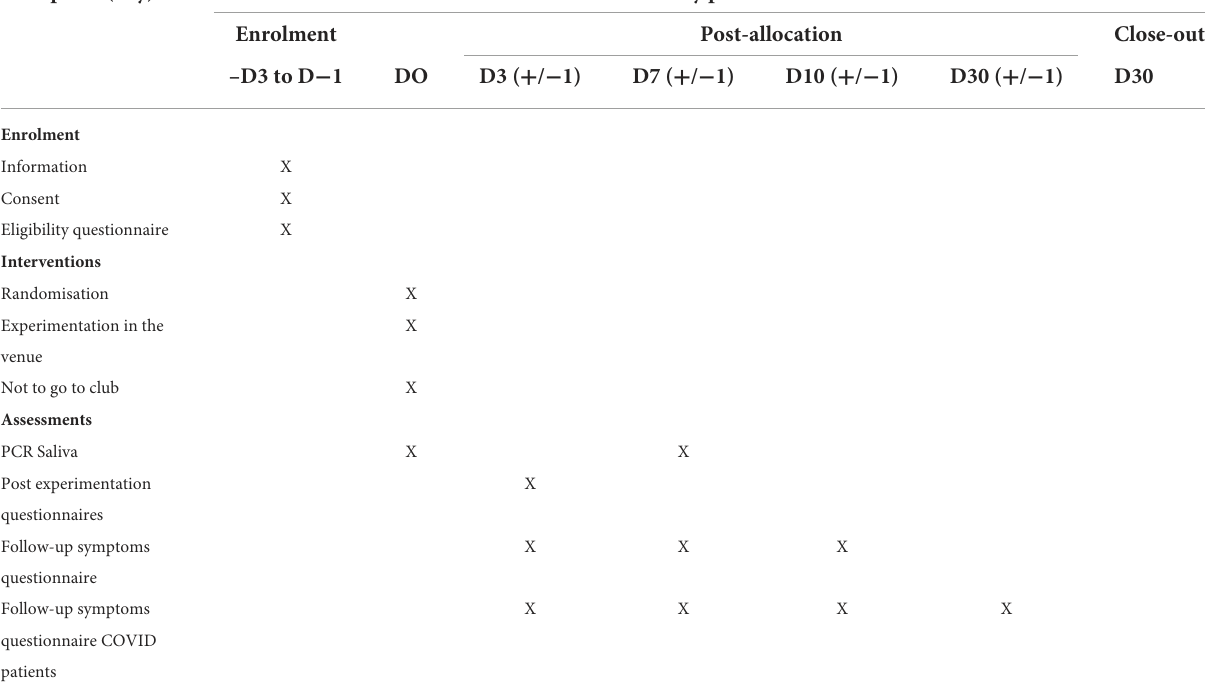
TABLE 1 Follow-up timeline for research